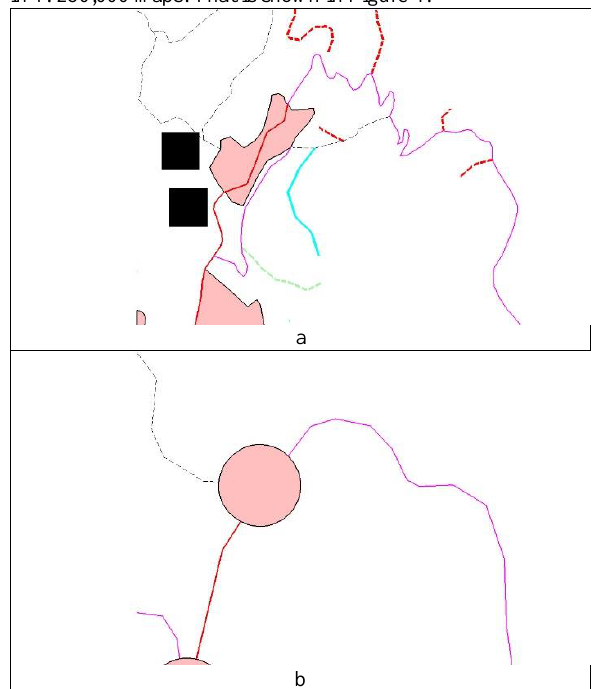
Figure 4. a: small polygons that shown before generalization. b: polygons covert to one point after generalization.